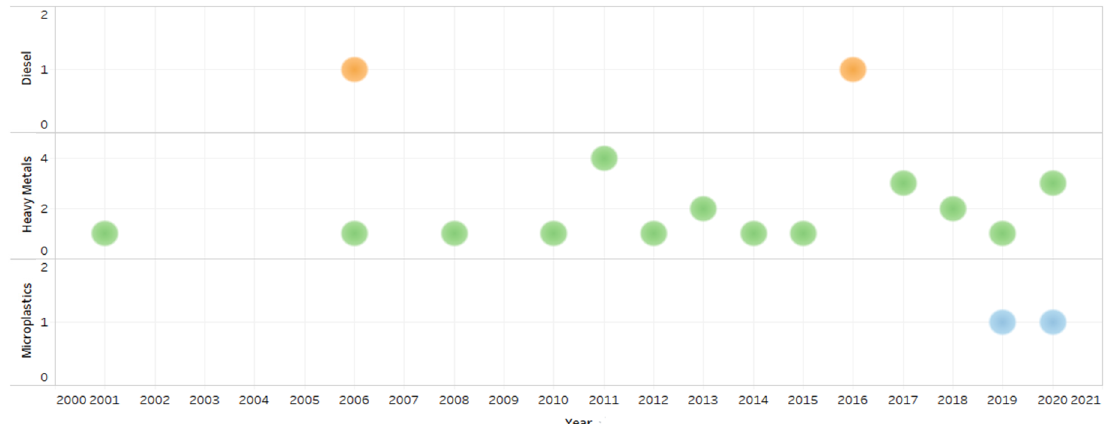
Figure 4. Chronological trend of published research articles on diesel, heavy metals and microplastics pollution among penguins in Antarctica from 2000 to